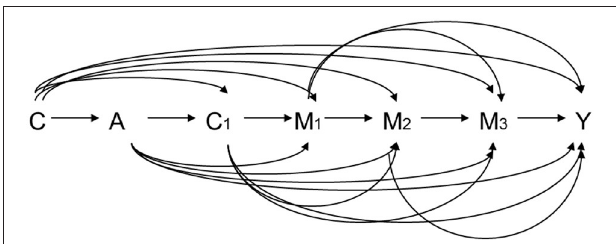
FIGURE 4 | Relation among exposure A, three ordering mediators M 1 , M 2 , and M 3 , outcome Y, baseline covariates C, and time-varying mediator-outcome confounder C 1 . A: exposure, M 1 : the first mediator, M 2 : the second mediator, Y: outcome, C: baseline covariates, C 1 : time-varying mediator-outcome